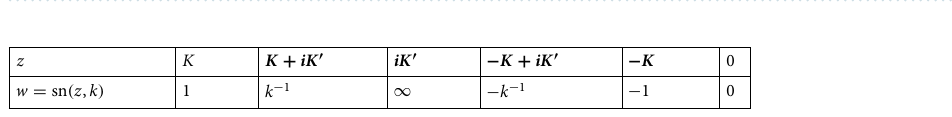
Table 1. Vertices of the rectangle in the z -plane and their corresponding vertices in the upper half of the w -plane in Fig. 2.